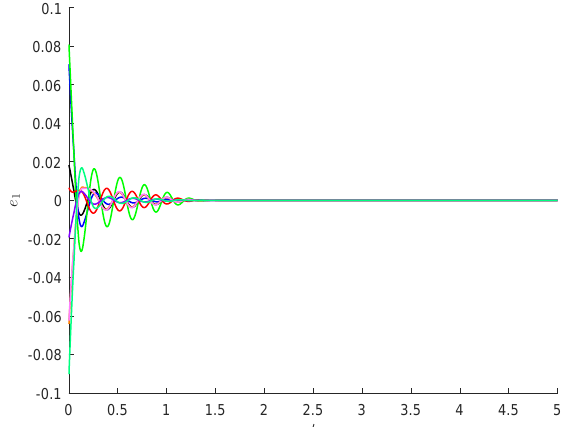
Figure 1. State trajectories of the error e 1 in Example 1, for 8 initial values (depicted with different colors). Best viewed in